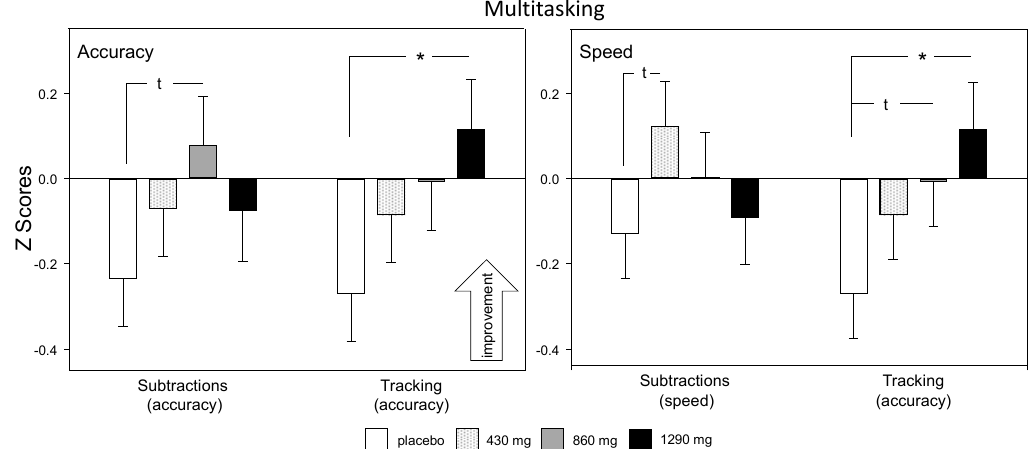
Figure 5. Acute (Day 1) treatment related change in multitasking performance averaged across 2 h and 4 h post-dose assessments. Left panel: subtractions accuracy (errors) and tracking accuracy, Right panel: subtraction speed (total number) and tracking accuracy. Scores for each measure were converted into standardised Z score, with a positive score indicating improved performance in order to analyse data together. Data shown are estimated means (plus SE) derived from the LMM analysis, using pretreatment baseline data and age as covariates. The data for tracking represented in both panels is the same, with differences in the planned comparisons relating to differences in variance across both tasks. t, p < 0.1; *, p < 0.05 in comparison to placebo at that time point. Chronic (Day 29) analysis: The initial analysis showed that there was a significant treatment × outcome interaction in terms of accuracy on the two tasks (F (3, 2067.12) = 10.5, p < 0.001). The planned comparisons of data averaged across the two measures (top-left panel of Figure 6) showed that 1290 mg green oat extract resulted in increased overall accuracy ( p = 0.03: d = 0.58). Reference to comparisons conducted on data from the individual outcomes (Figure 6, top-right panel) showed that this effect was predominantly due to improved tracking task performance following 1290 mg green oat extract ( p < 0.001: d = 0.94) with an additional significant improvement on this measure following 430 mg ( p = 0.032: d = 0.54). Of note, given that subtraction accuracy was numerically higher in all the green oat extract treatments than in placebo, the possibility that improved tracking had a detrimental influence on subtraction performance can be excluded.